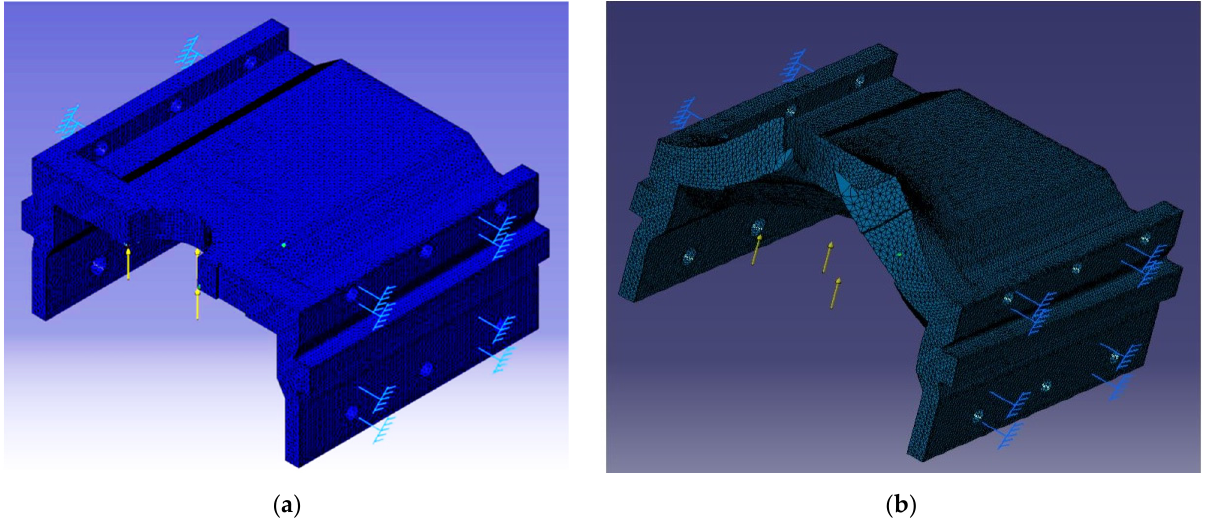
Figure 9. The loads and restrictions imposed on the trimming die for FEM modeling: ( a )—undeformed trimming die; ( b )—deformed trimming